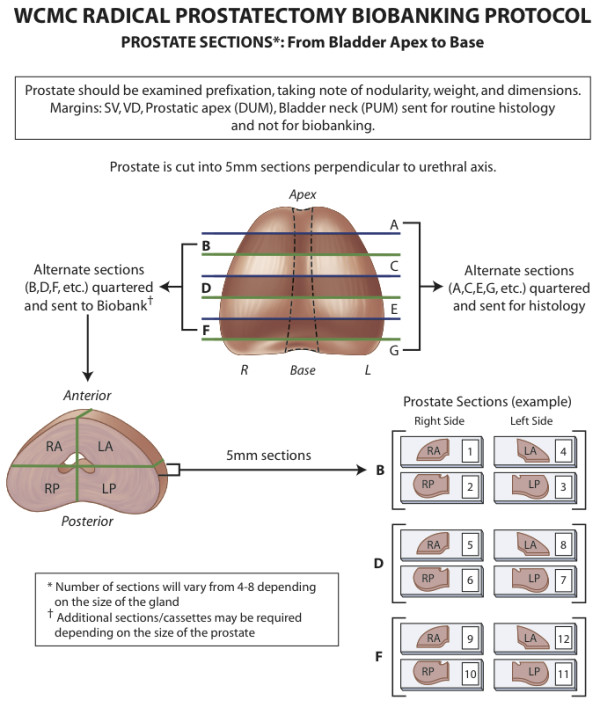
WCMC radical prostatectomy biobanking protocol.